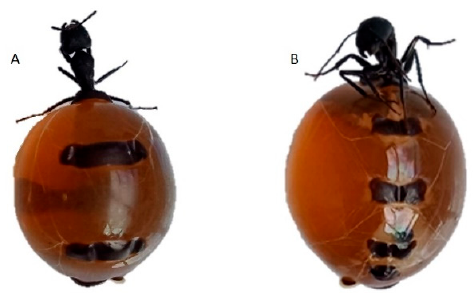
Figure 1. Australian honeypot ants’ posterior (dorsal) side view ( A ) and anterior (ventral) side view ( B ).